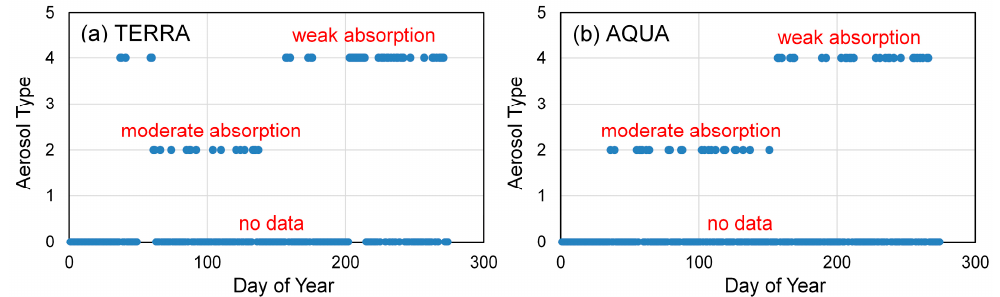
Figure 12. Time series (January 1–September 30, 2016) of aerosol type information collected from ( a ) TERRA and ( b ) AQUA MODIS aerosol products.